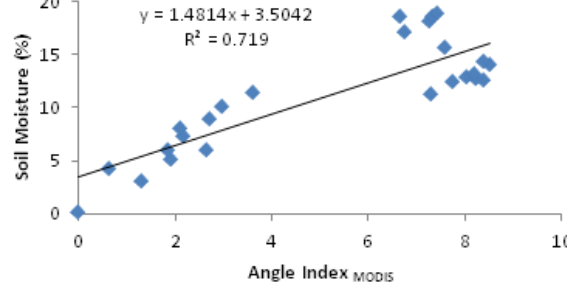
Furthermore, Angle index was calculated for spectral reflectance equivalent to bands 3, 4,5,6,7 MODIS Which has a spatial resolution of 500m (Fig.12).